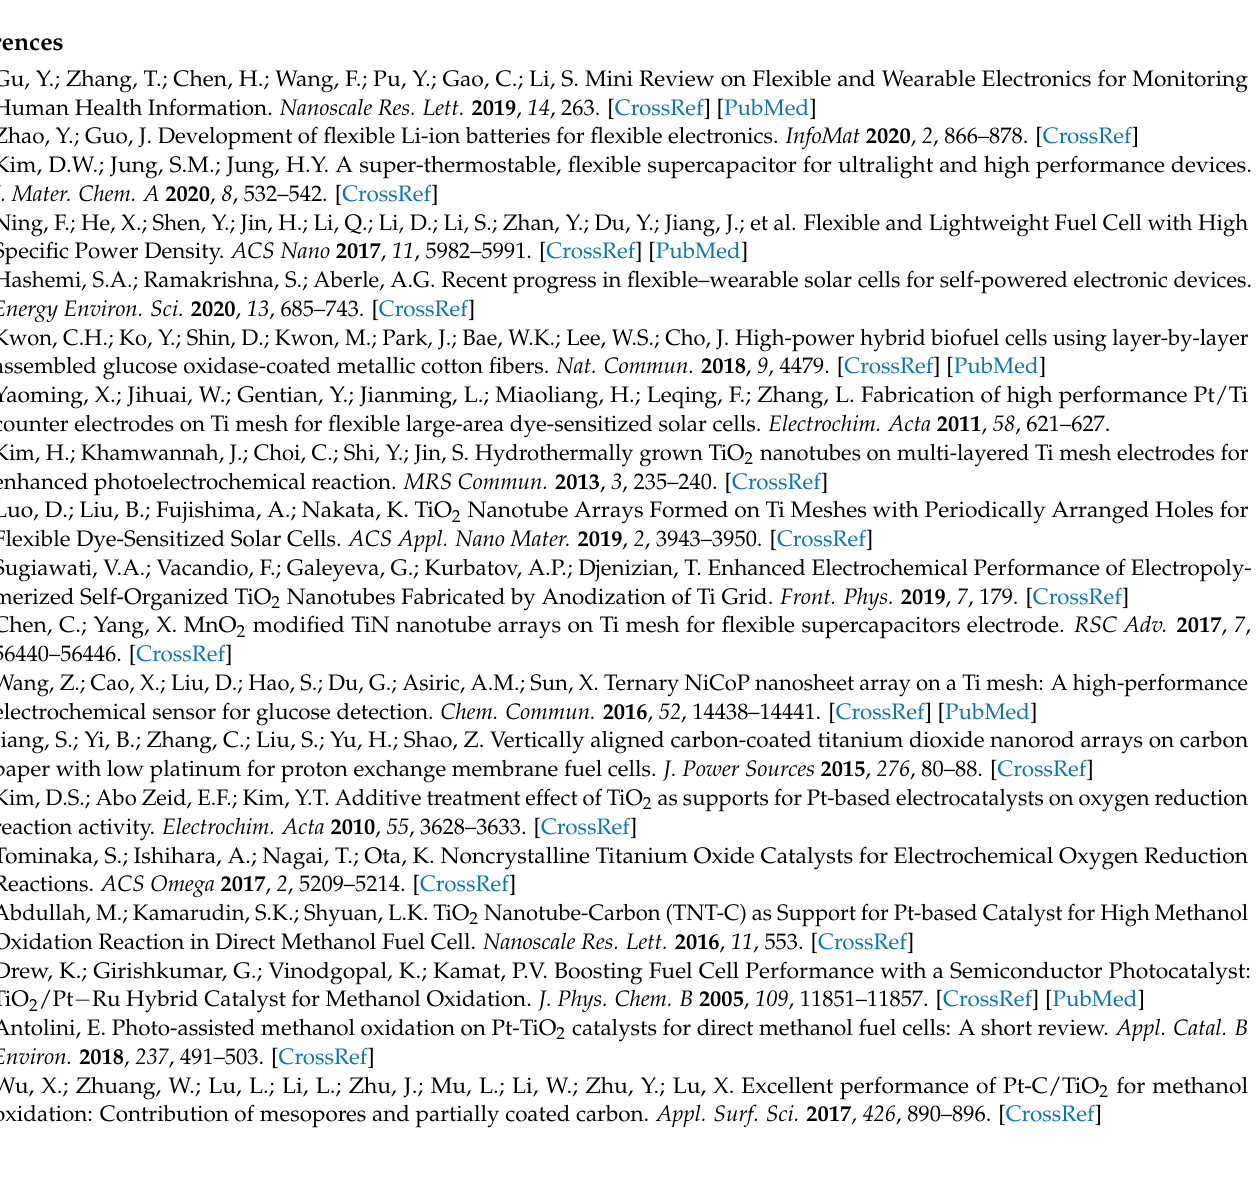
magnifications of pristine Ti mesh. Figure S2: XPS survey scan of Pt film grown onto TiO 2 nanorods; Figure S3: Cyclic voltammetry in 0.5 M H 2 SO 4 + 1 M C 2 H 5 OH solution with a potential scan rate of 5 mV s − 1